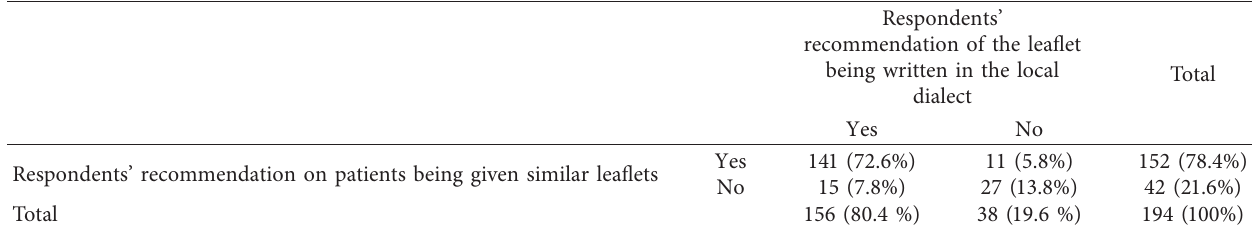
Table 4: Respondents’ recommendations on patients being given similar information leaflets and leaflets being written in the local